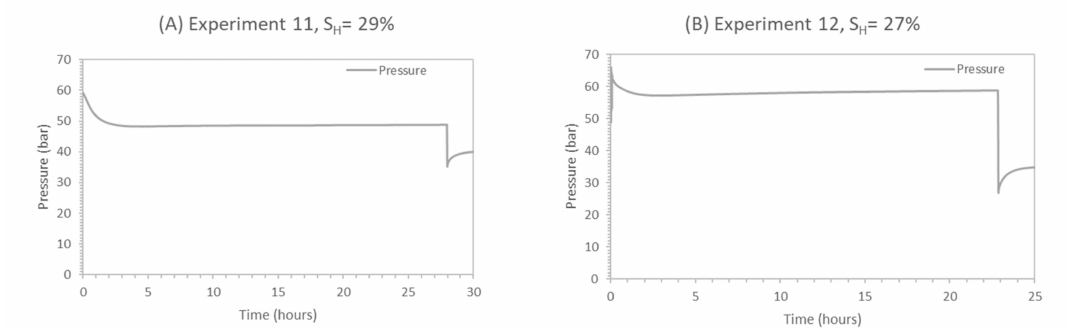
Figure 16. Pressure profiles for CH 4 -CO 2 replacement process 24 h after soaking during experiment 11 and experiment 12. These experiments were performed at T = 4 ◦ C. Experiments were performed with di ff erent S wi and in the presence of 5 wt% of MeOH in the water. Sudden drop in pressure at the end of 24 h corresponds to gas collection for GC analysis followed by controlled depressurization. ( A ) Pressure profile after CO 2 injection and during the soaking period in experiment 11 ( B ) Pressure profile after CO 2 injection and during the soaking period in experiment